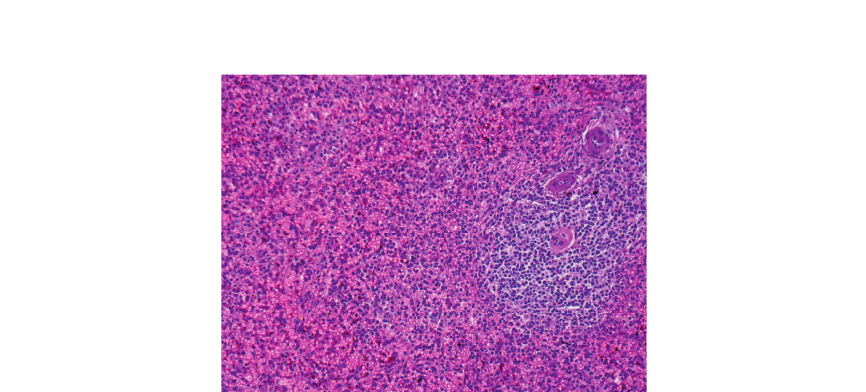
Figure 3: The spleen was 244.5gm showing red pulp congestion, but no abnormal cell population. The perivascular white pulp is intact but